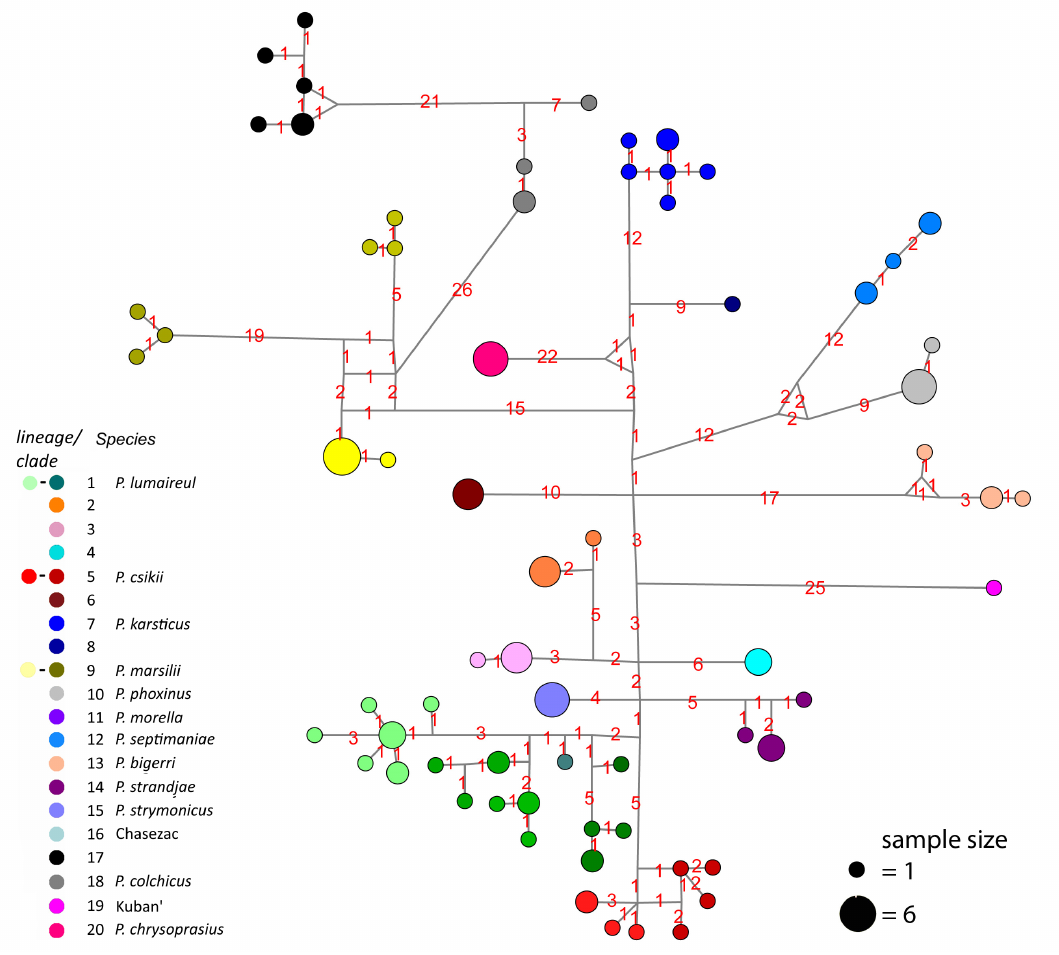
Fig. 2. A haplotype network based on cytochrome oxidase I (CO1) fragment using 112 previously pu- blished GenBank sequences and representing 20 genetic clades numbered as in Palandačić et al. (2017, 2020), of which 12 are considered valid species including P. chrysoprasius (Pallas, 1814) and Kuban’ Phoxinus (an available species name not known). The lines carry the number of mutational steps (shown in